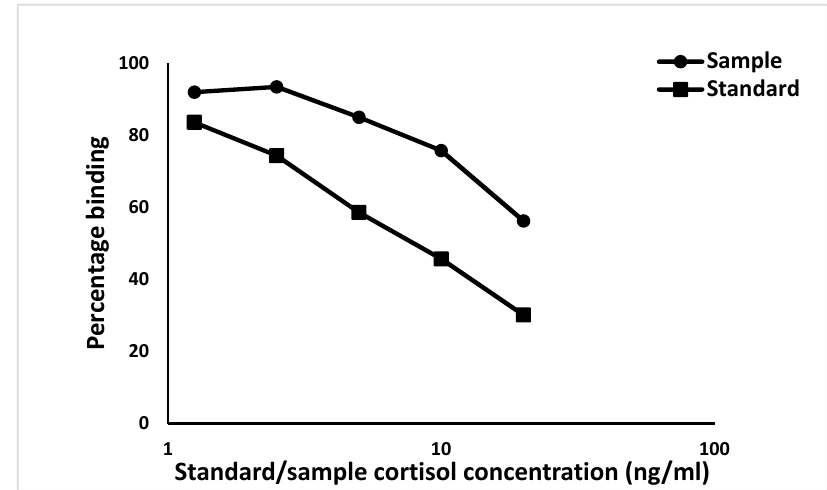
Figure 1. The parallelism between the serial dilution of pooled hair extracts of cow samples and cortisol standards.